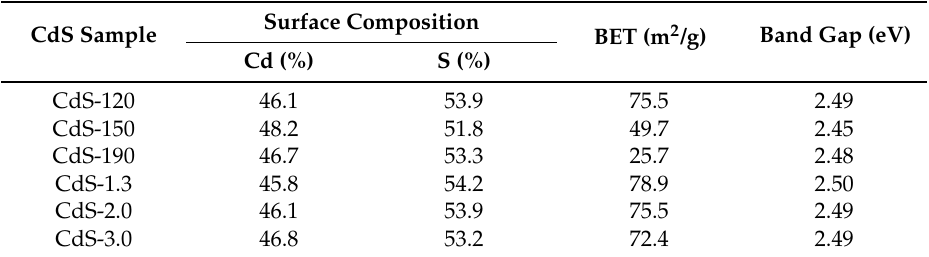
Table 1. Surface composition (atomic percentage) from TXRF analyses, specific surface area from N